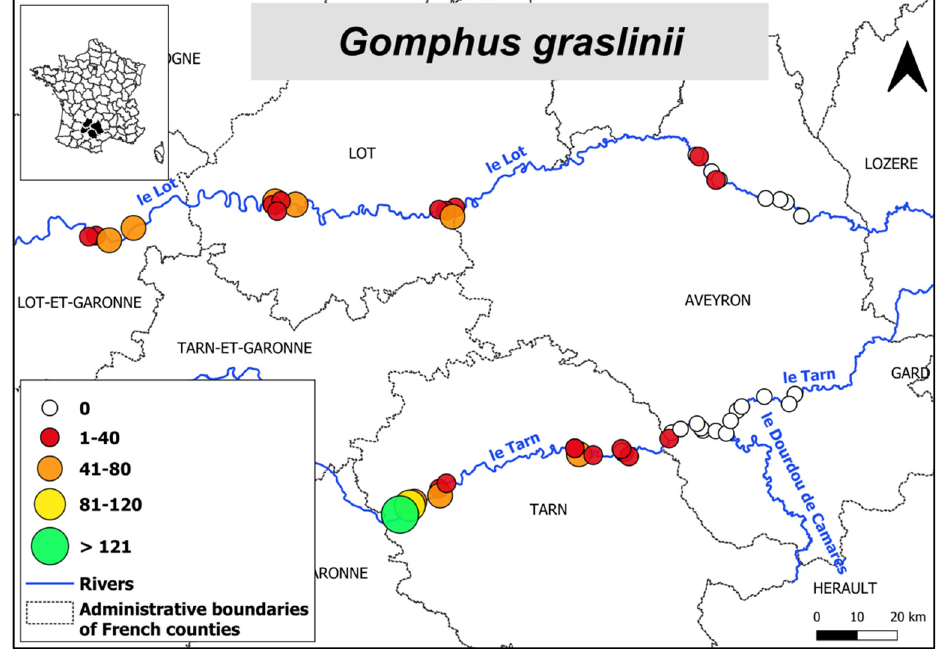
Figure 3. Distribution maps of exuviae of the three species of community interest Oxygastra curtisii , Macromia splendens and Gomphus graslinii . Bold lines and bold names indicate the rivers Tarn, Lot, and Dourdou de Camarès. The gradient of colour and size of the circles highlights the differences in numbers of exuviae.